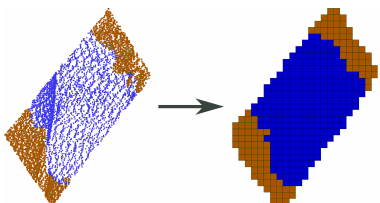
Figure 6. Mapping of measurement data to grid cells and their classification in land grid cells (brown) and water grid cells